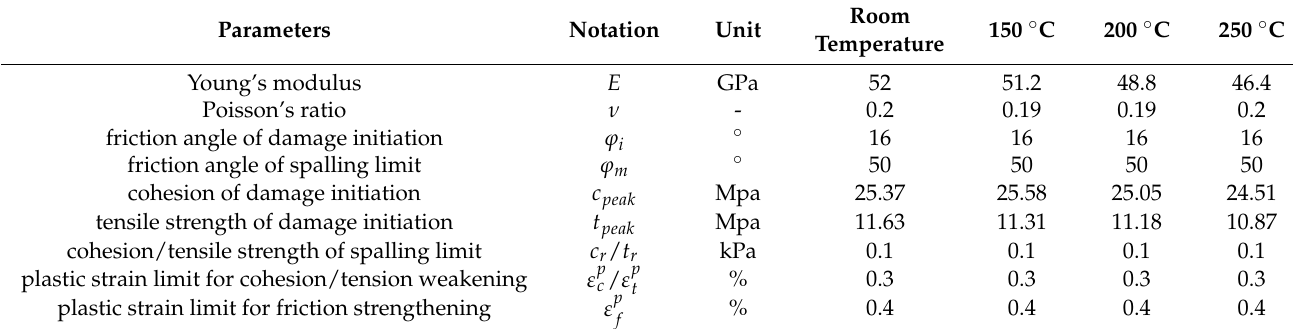
Table 2. Rock mechanical parameters under various temperatures adopted in modelling.